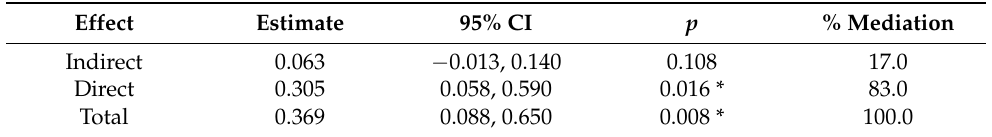
Table 6. Mediation analysis exploring the effect of triangular/lambda pattern on 30-day mortality mediated by primary ventricular fibrillation.